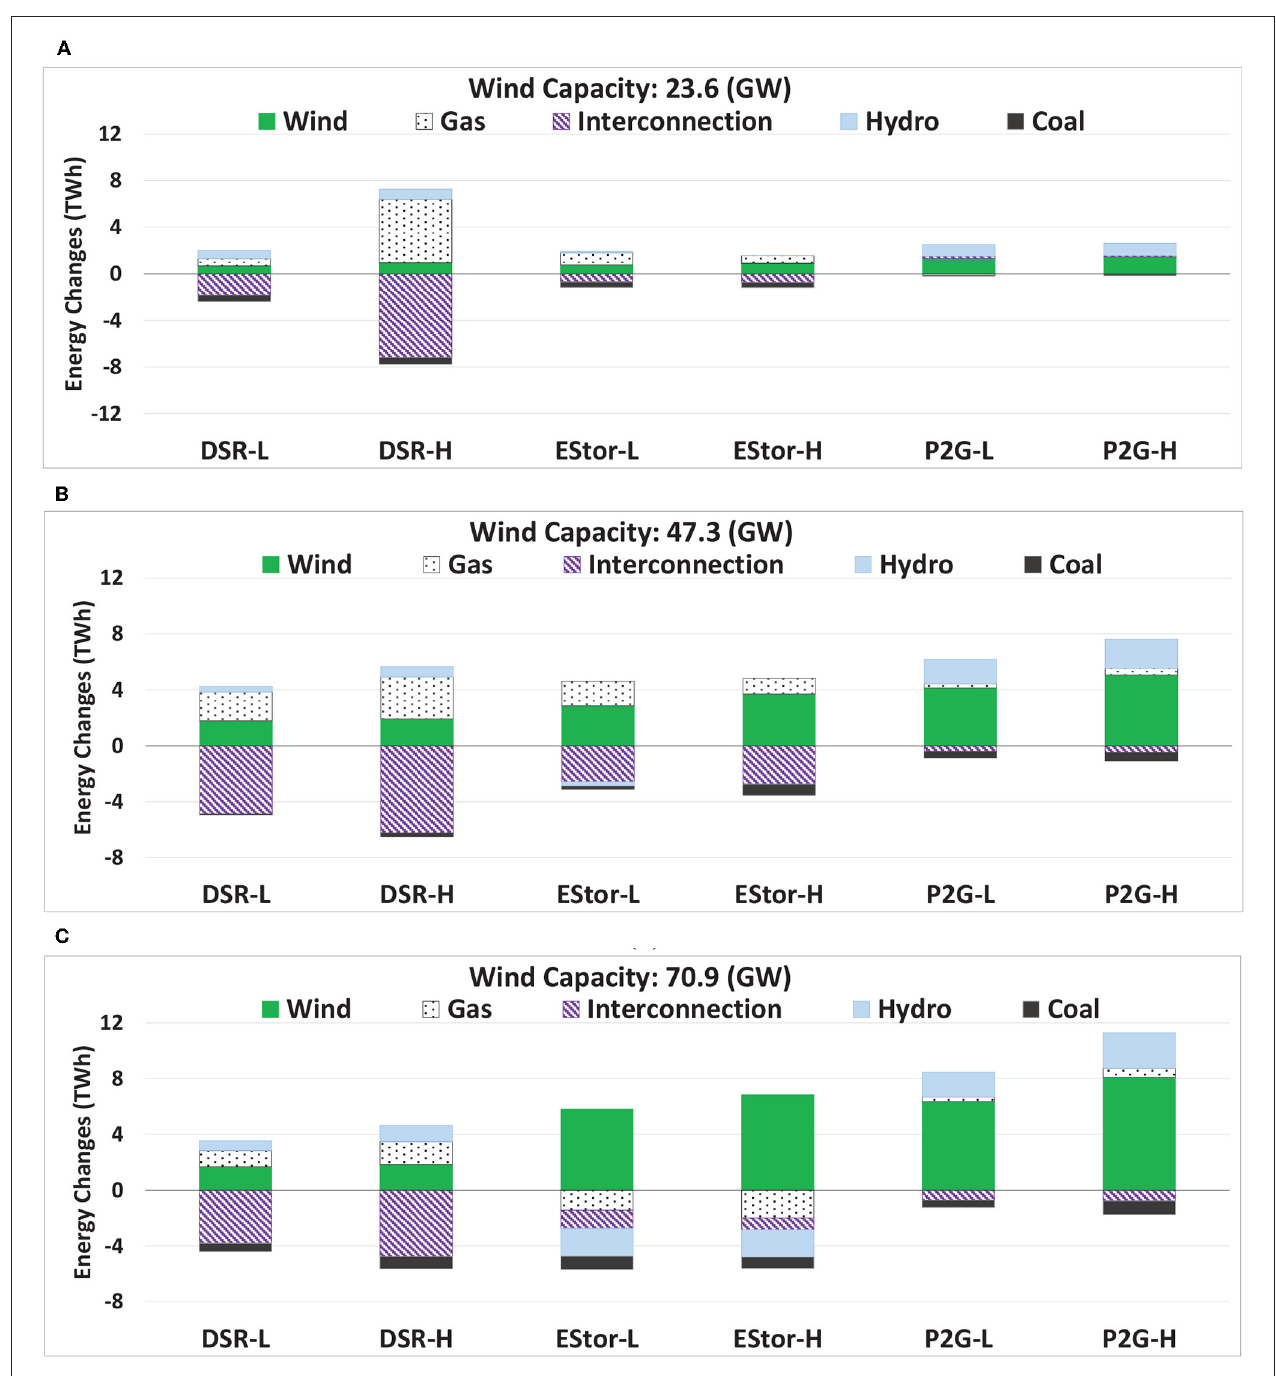
FIGURE 5 | Annual energy changes for different installed capacities of wind (compared to the Ref case): (A) 23.6 GW, (B) 46.7 GW, and (C) 70.9